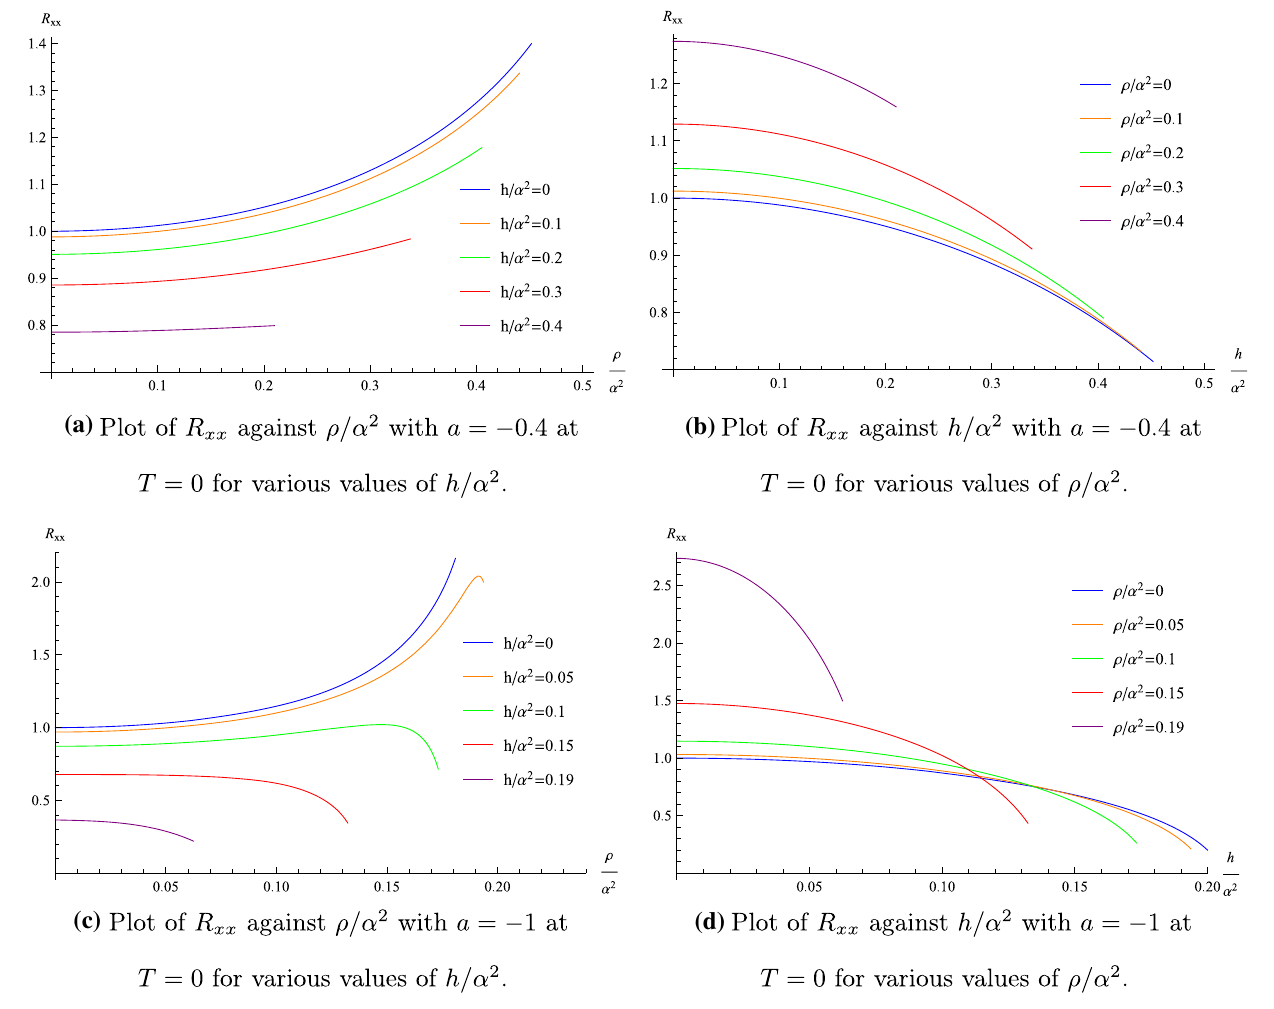
Fig. 7 Plots of R xx against the charge density ρ and the magnetic field h with a = − 0 . 4 and a = − 1 at T = 0 for Born-Infeld